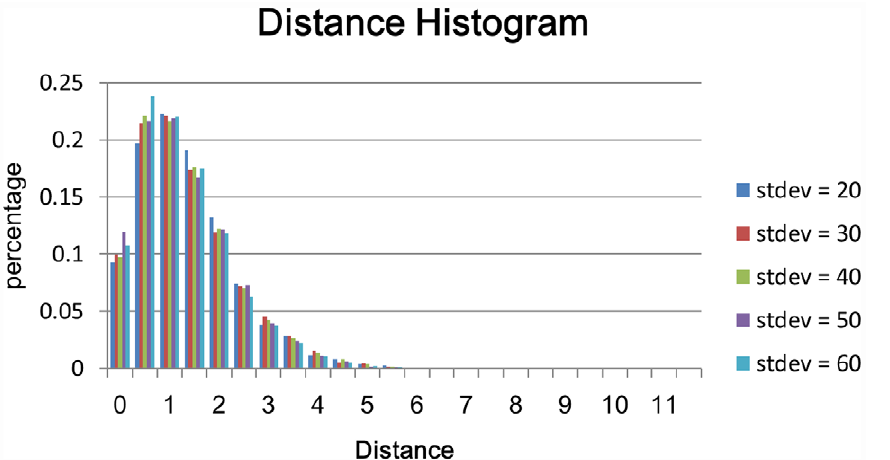
PLOS Computational Biology |